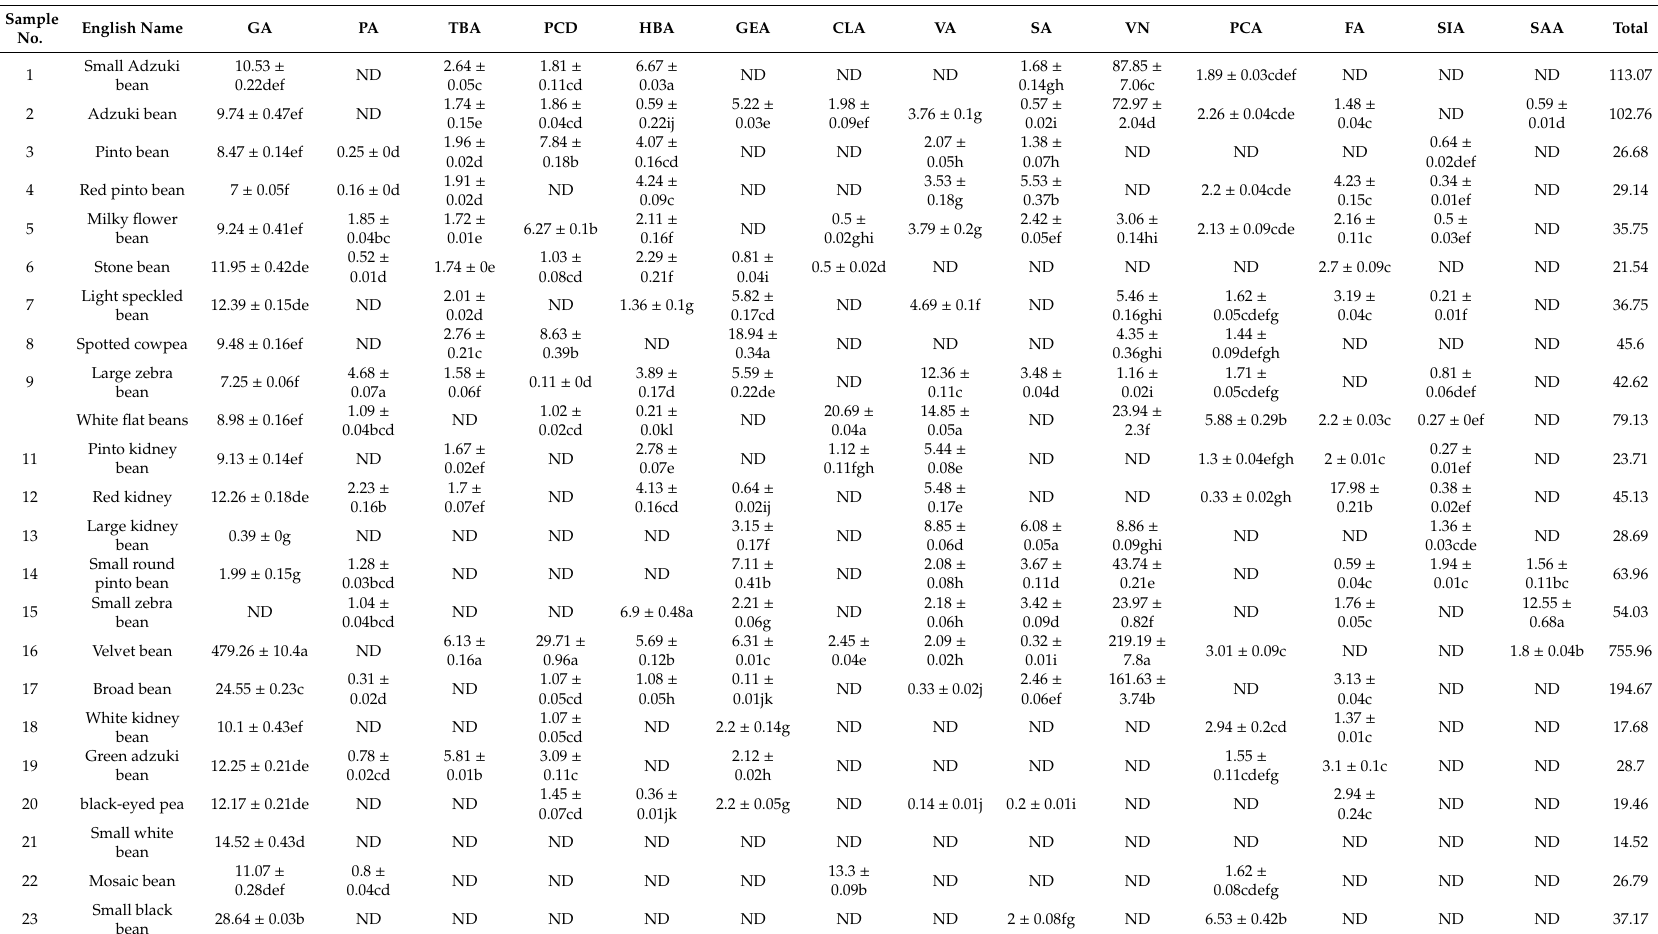
Table 4. The free phenolic acid contents ( µ g / g) of legume samples.